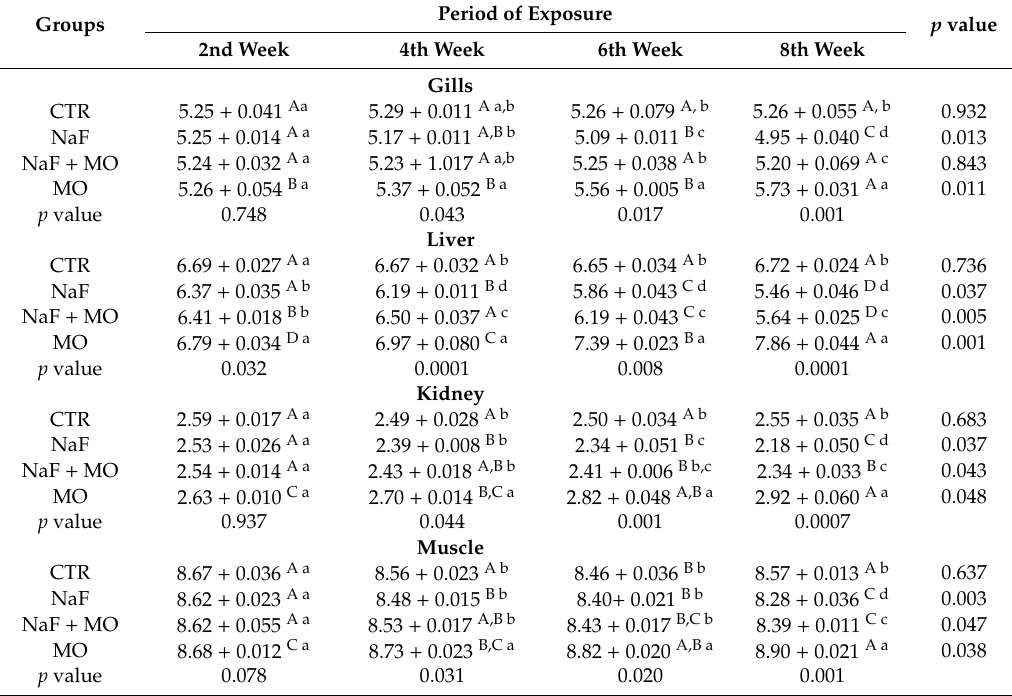
Table 5. E ff ect of Sodium fluoride (NaF) and / or M. Oleifera (MO) on glutathione reduced (GSH) (U / g tissue) in tissue homogenates of O. niloticus gills, liver, kidney, and muscle.